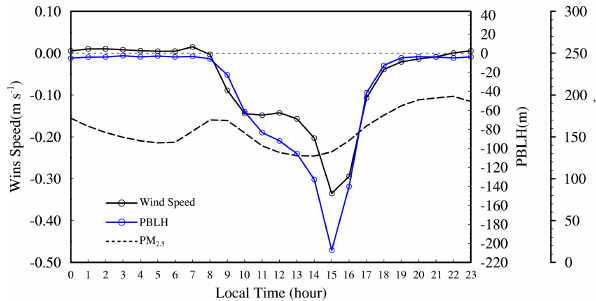
Figure 10. Time series of diurnal variation of surface PM 2 . 5 con- centration from EXP_CTL and aerosol-induced diurnal change of wind speed (ms − 1 ) and PBLH (m) averaged for the BTH region and the period 10–15 January